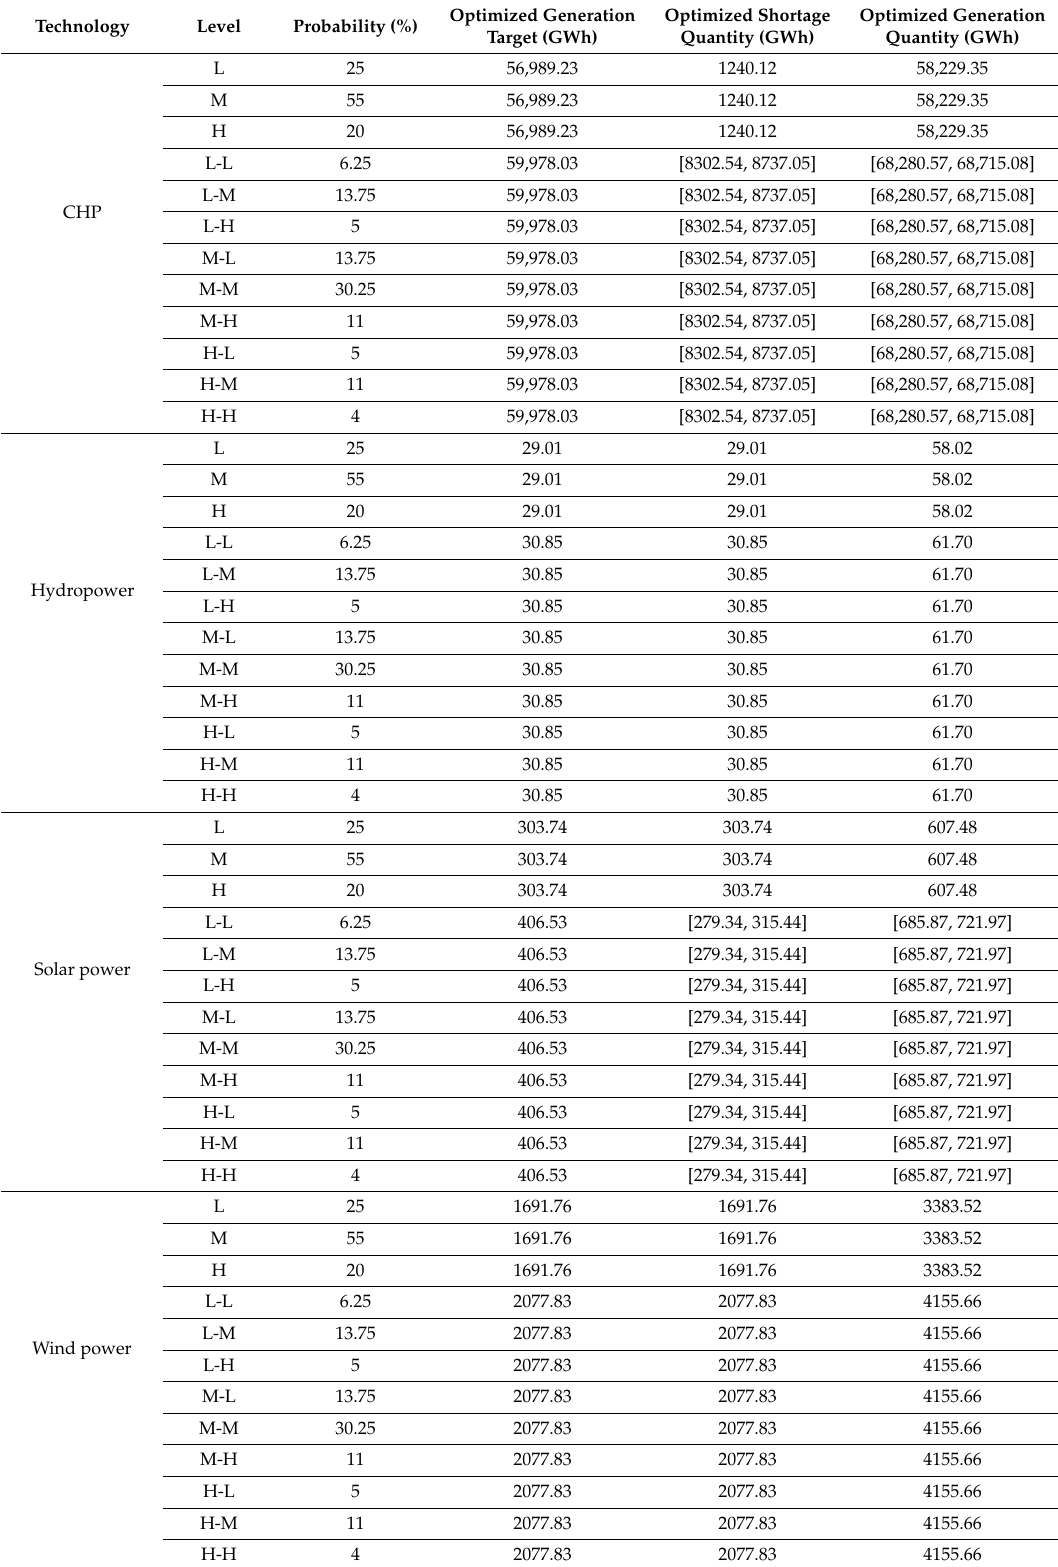
Table 2. The optimized power generation schemes under λ =